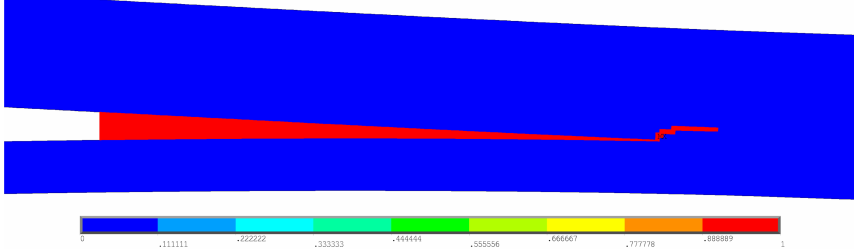
Figure 10. Contour plot of the damage variable by the model without any interactive module.